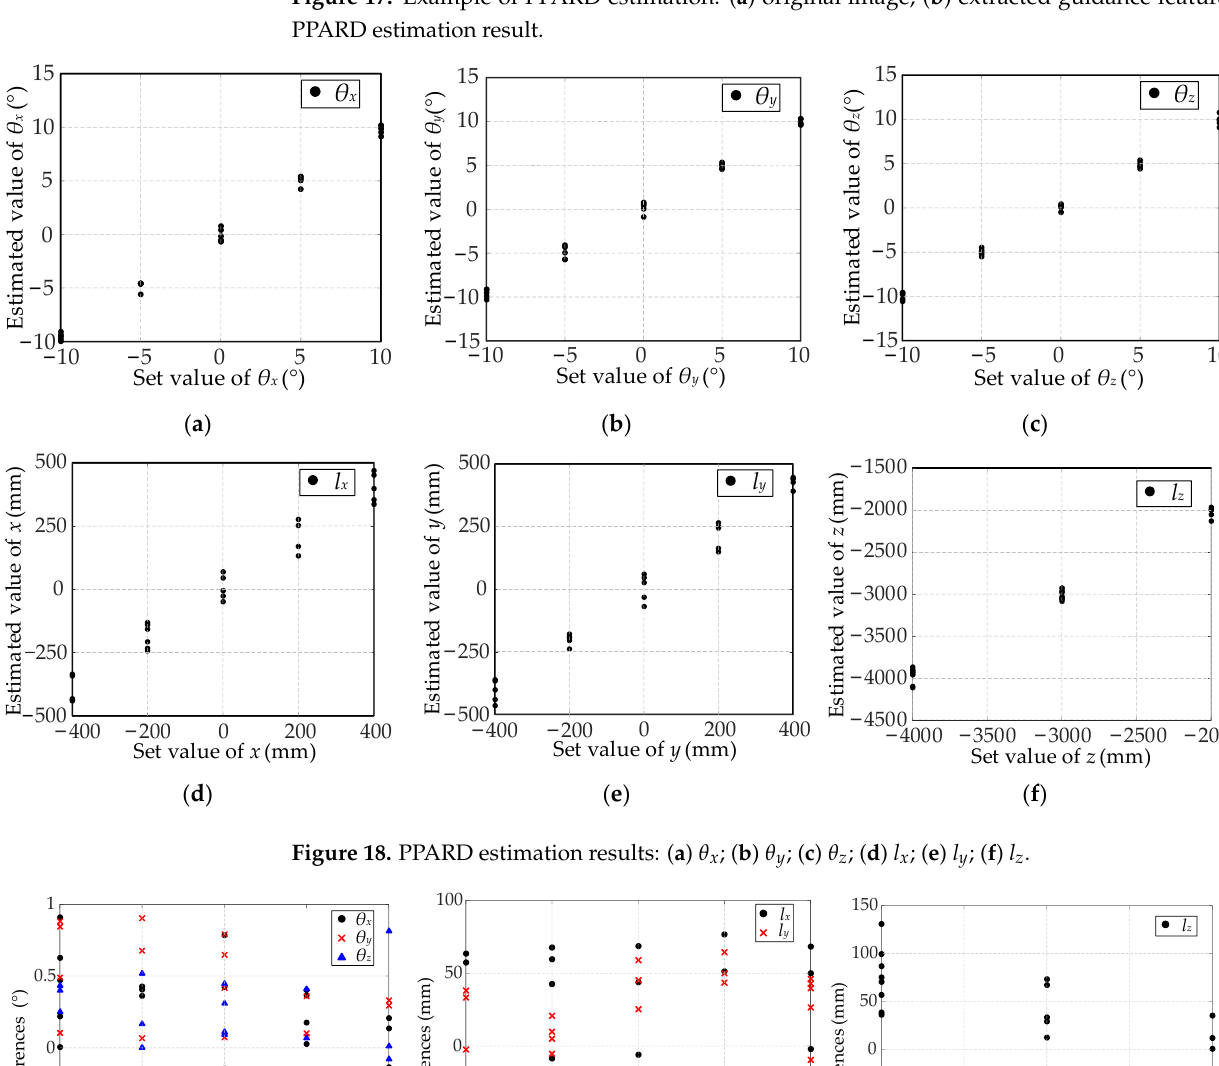
Figure 18. PPARD estimation results: ( a ) θ x ; ( b ) θ y ; ( c ) θ z ; ( d ) l x ; ( e ) l y ; ( f ) l z .